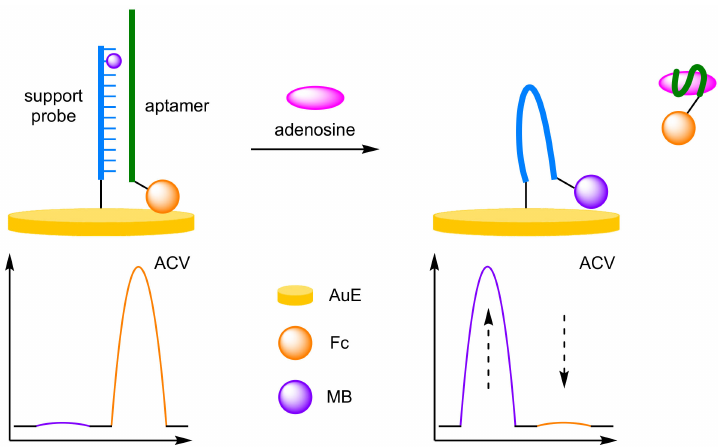
Figure 6. Schematic representation of an aptamer-based biosensor for the detection of adenosine.